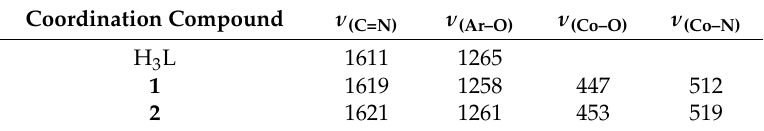
Table 3. Main IR bands (cm − 1 ) for the ligand H 3 L and its coordination compounds 1 and 2 .